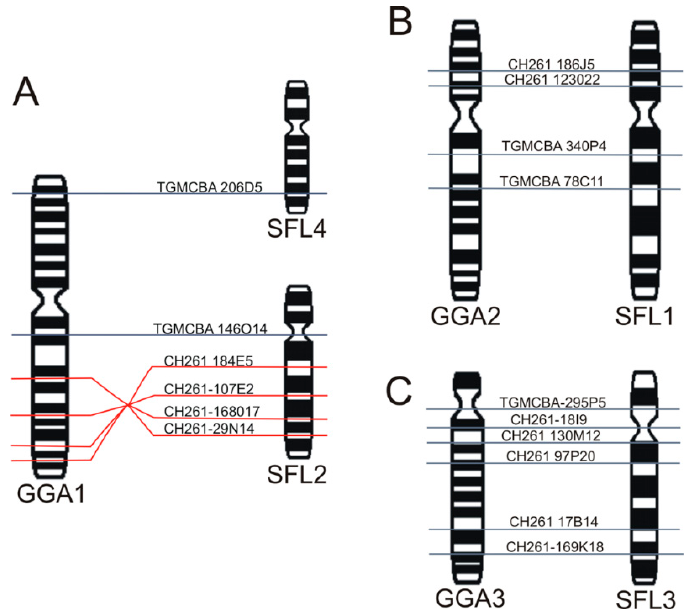
Figure 5. Schematic representation of BAC clones from Gallus (CH261) or Taeniopygia guttata (TGMCBA) homologous to G . gallus chromosome 1 (GGA 1) ( A ), chromosome 2 (GGA 2) ( B ), and chromosome 3 (GGA 3) ( C ) in Sicalis flaveola (SFL). Ideograms are represented with G ‐ banding patterns. G ‐ banding data from G . gallus followed Ladjali ‐ Mohammedi et al. [50].